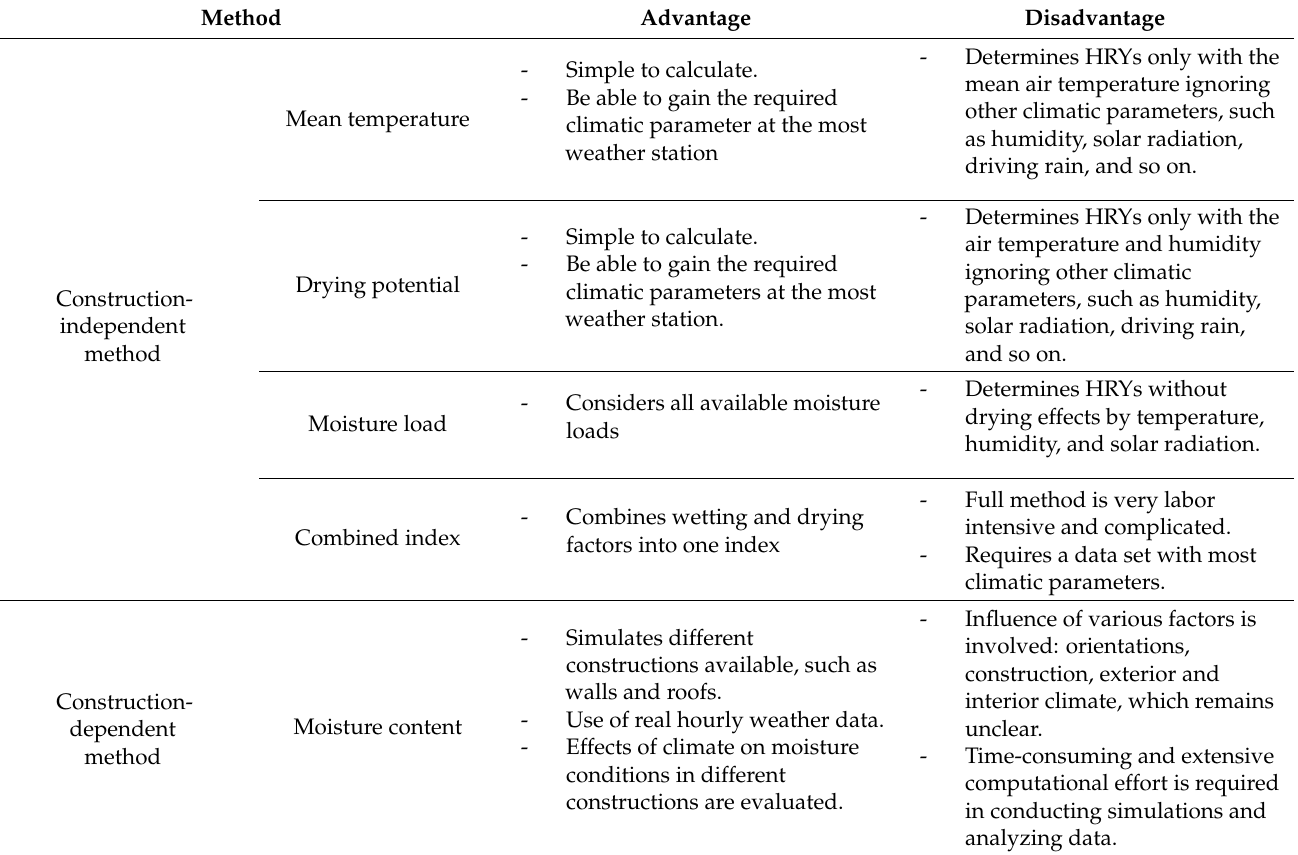
Table 4. Advantages and disadvantages of different selection methods for hygrothermal reference